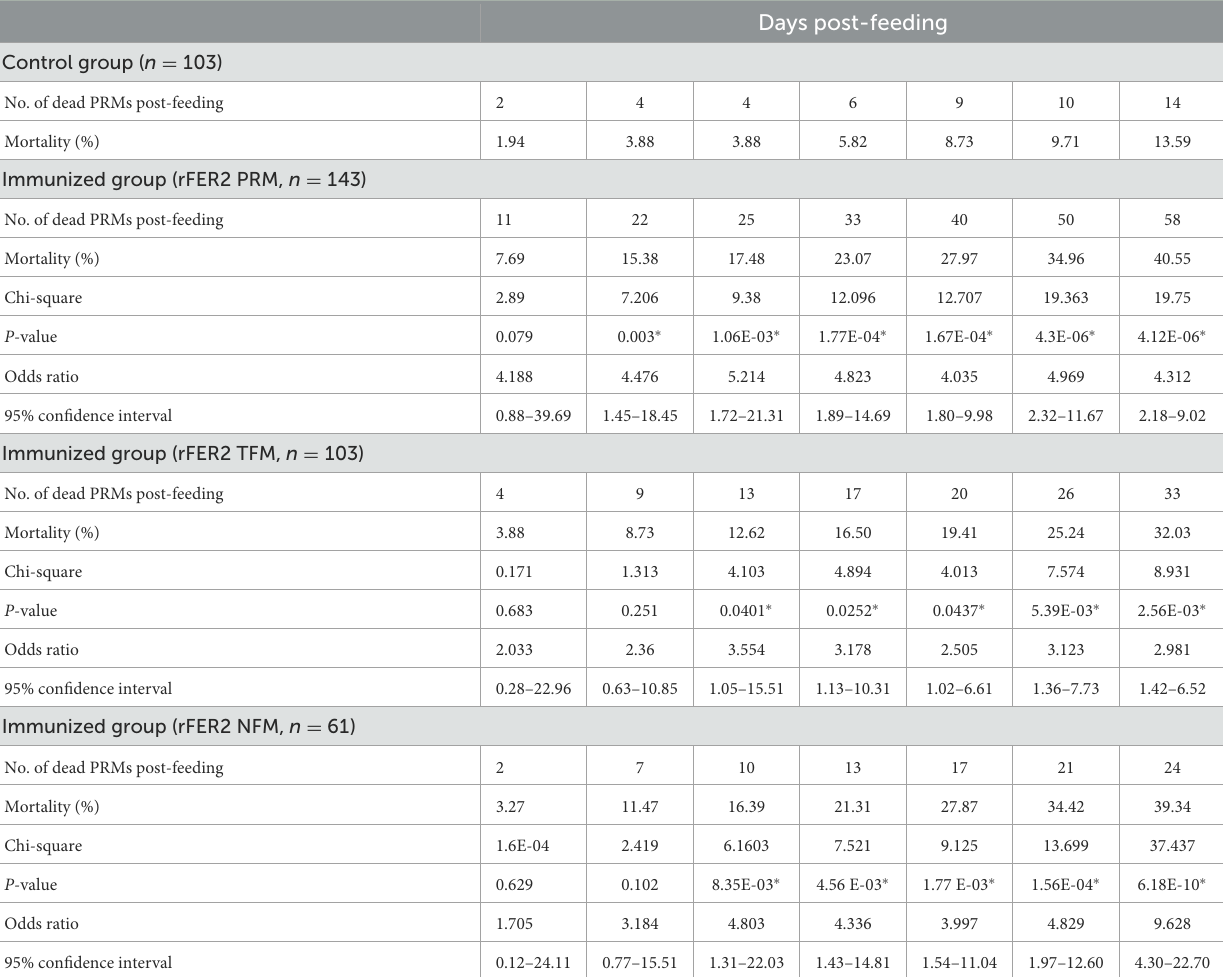
TABLE 3 Mortality of PRMs fed plasma from chickens immunized with recombinant ferritin 2 from different species of mites (experiment 1).